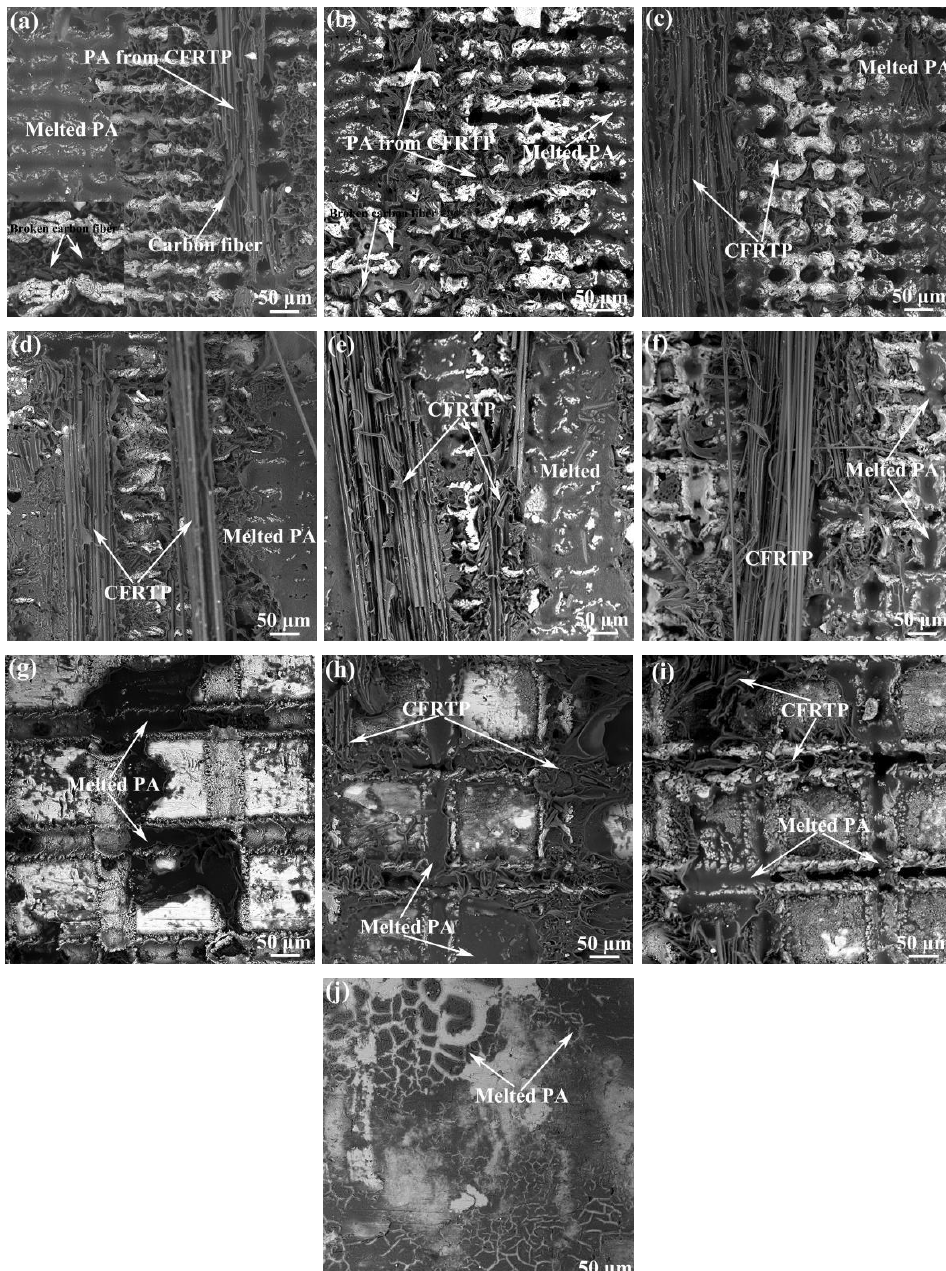
Figure 7. Fracture surface of the Al/CFRTP butt joint with different pretreated Al joining interface: ( a ) d = 0.05 mm and n = 1 (inset image showing the broken carbon fiber), ( b ) d = 0.05 mm and n = 2 (inset image showing the broken carbon fiber), ( c ) d = 0.05 mm and n = 4, ( d ) d = 0.1 mm and n = 1, ( e ) d = 0.1 mm and n = 2, ( f ) d = 0.1 mm and n = 4, ( g ) d = 0.2 mm and n = 1, ( h ) d = 0.2 mm and n = 2, ( i ) d = 0.2 mm and n = 4, and ( j ) untreated (d: laser scanning distance, n: laser scanning